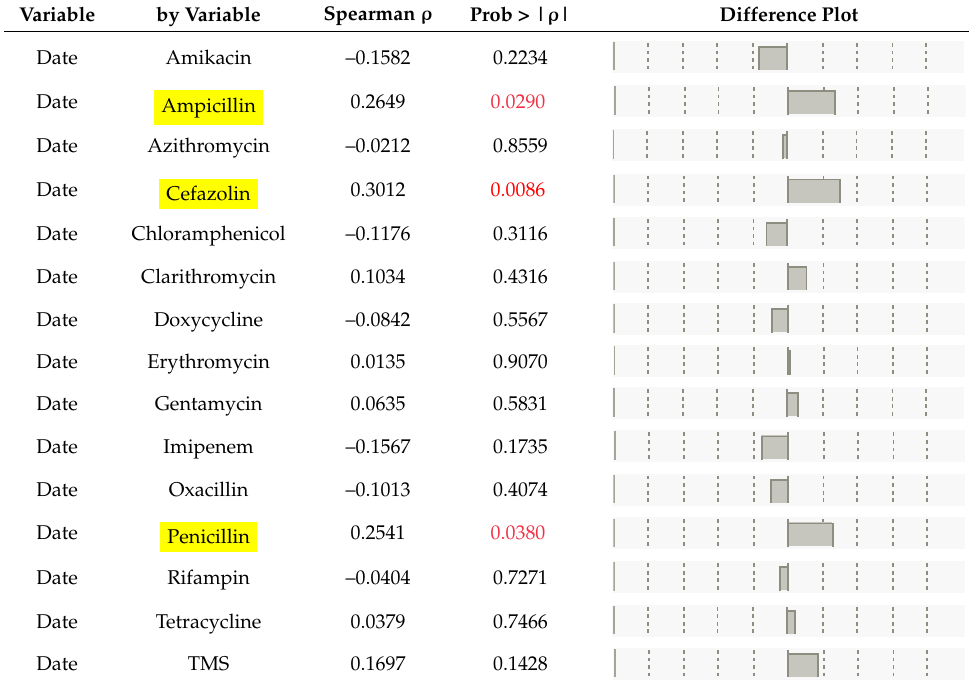
Table 2. Antibiotic resistance over a ten-year time period. Variable by Variable Spearman ρ Prob > | ρ | Difference Plot